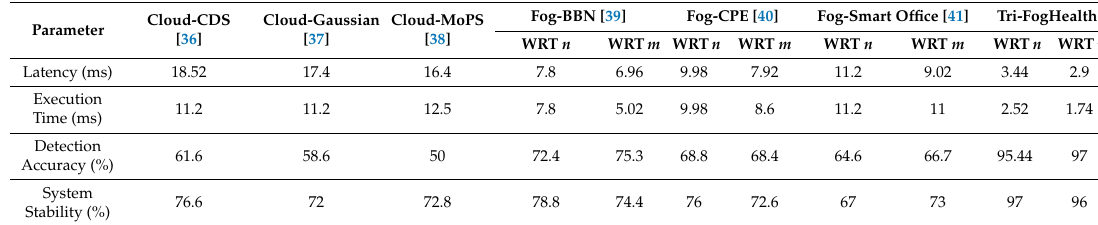
Table 7. Numerical Comparison on Obtained Results.